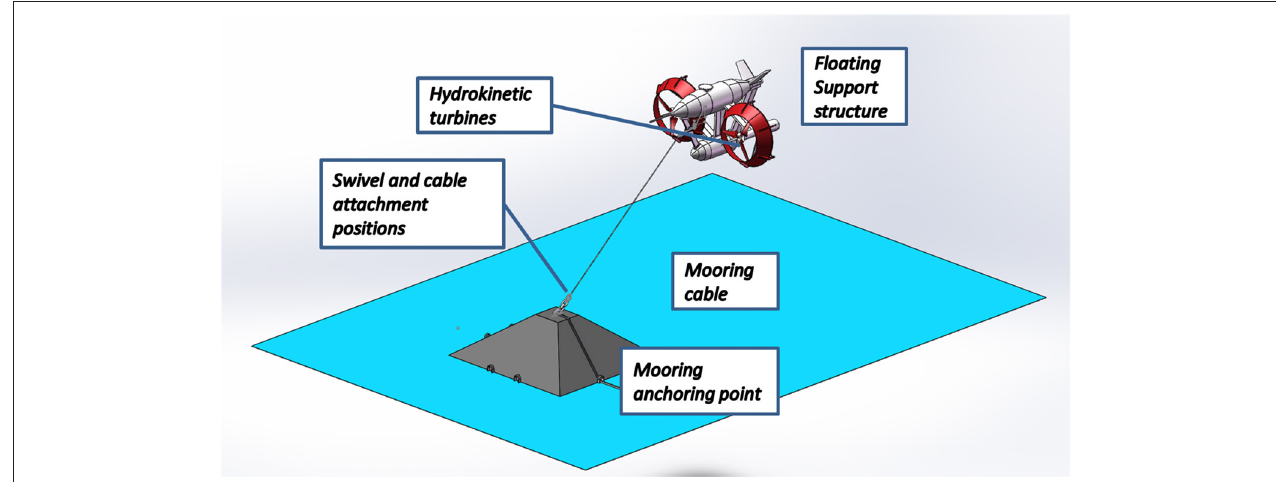
FIGURE 2 | Schematic view of GEM